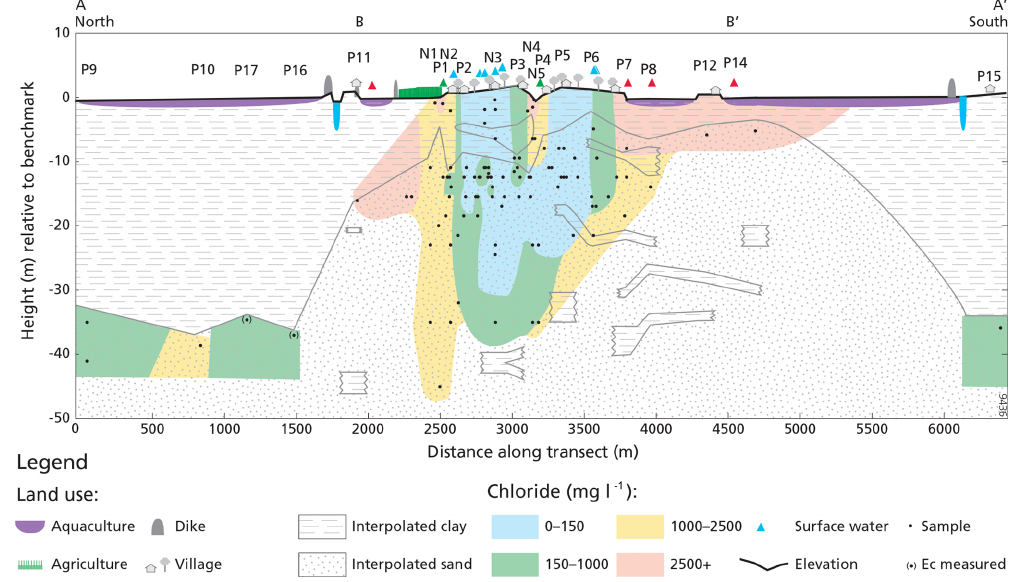
Figure 3. Salinity of the sampled groundwater, of phreatic water sampled in clay just below the surface and of sampled surface water